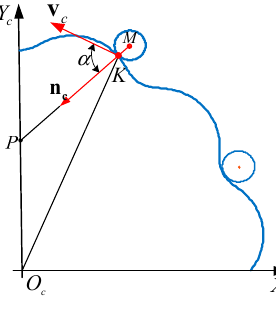
Figure 2. Pressure angle of the cycloidal profile.